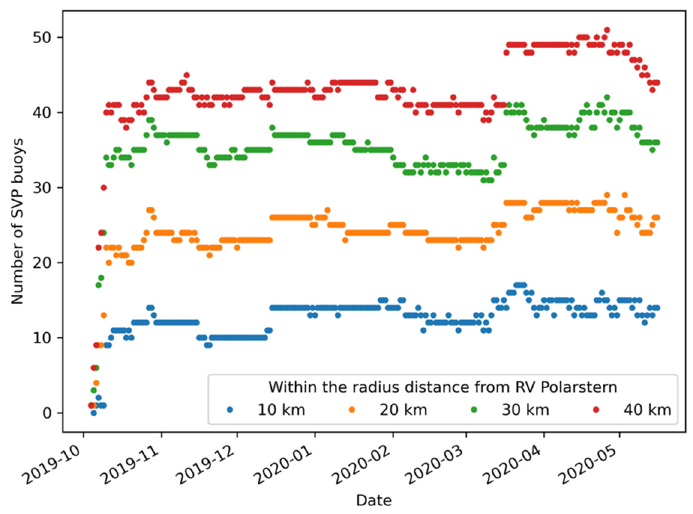
Figure 2. Number of the surface velocity profiler (SVP) buoys around the RV